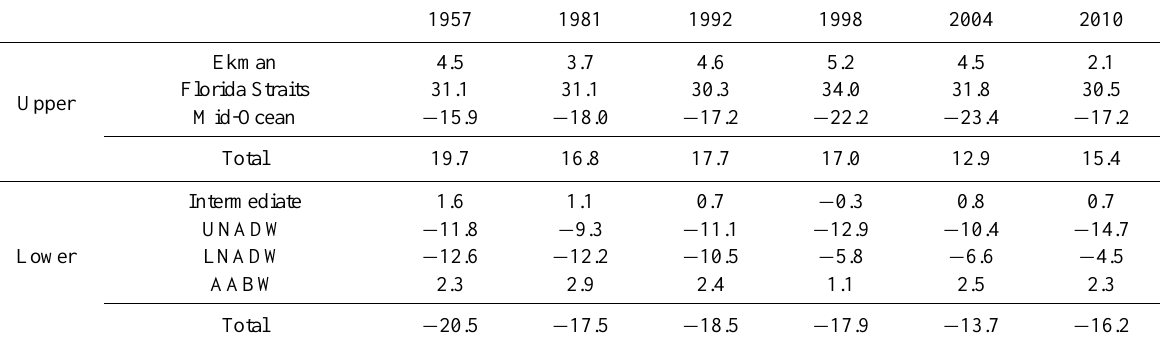
Table 4. Northward transport (Sv) in depth classes for the six hydrographic sections. The upper layer comprises transport in the Ekman layer, Florida Straits and mid-ocean ( ≤ 800m), the lower layer comprises mid-ocean only ( > 800m); for full class definitions see Table 3. Ekman transports (zonally integrated across 25 ◦ N) and Florida Straits transports are annual averages calculated from wind stress climatologies and cable observations, respectively (Sect. 2.3). Net imbalance between upper and lower layer total transports is due to Bering Straits inflow (0.8Sv) to the North